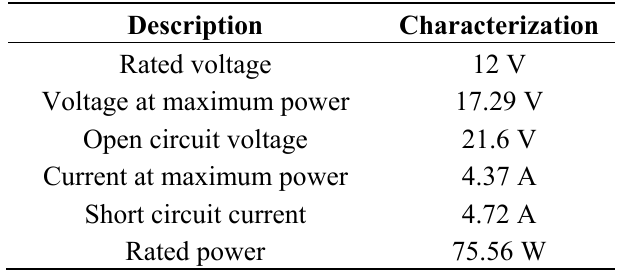
Table 4. Characteristics of the 80 W PV generator.